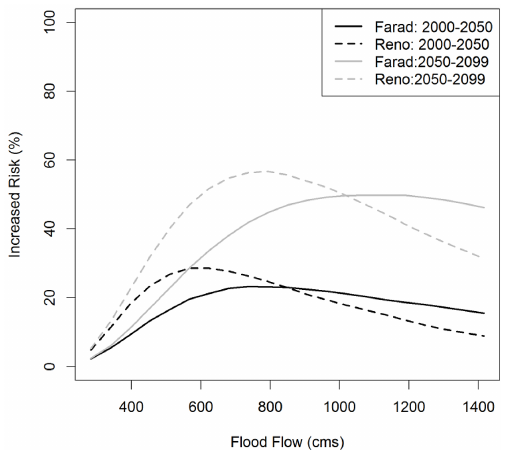
Figure 9. Increased probability of flood occurrence for a 10-year project life (risk) from the historical period (1950–1999) to each of the two future periods, 2000–2050 (black) and 2050–2099 (grey). Farad is plotted with a solid line and Reno is a dashed